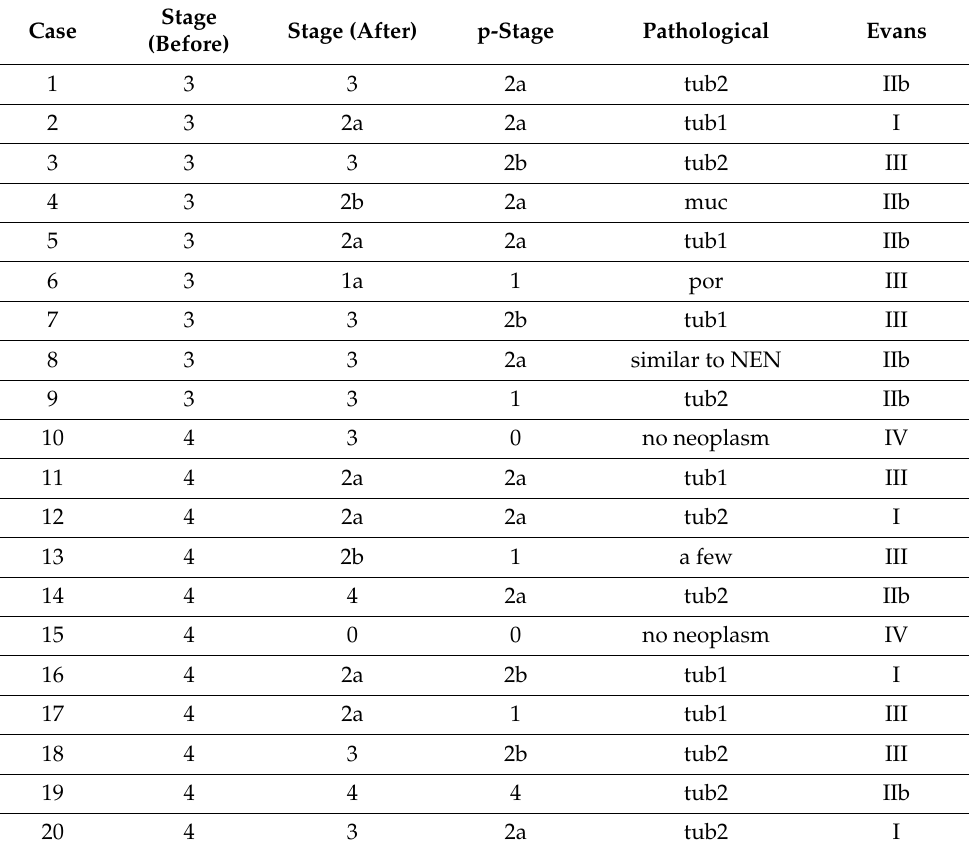
Table 3. Clinical characteristics of 20 patients who underwent conversion surgery. Each stage was classified according to the TNM